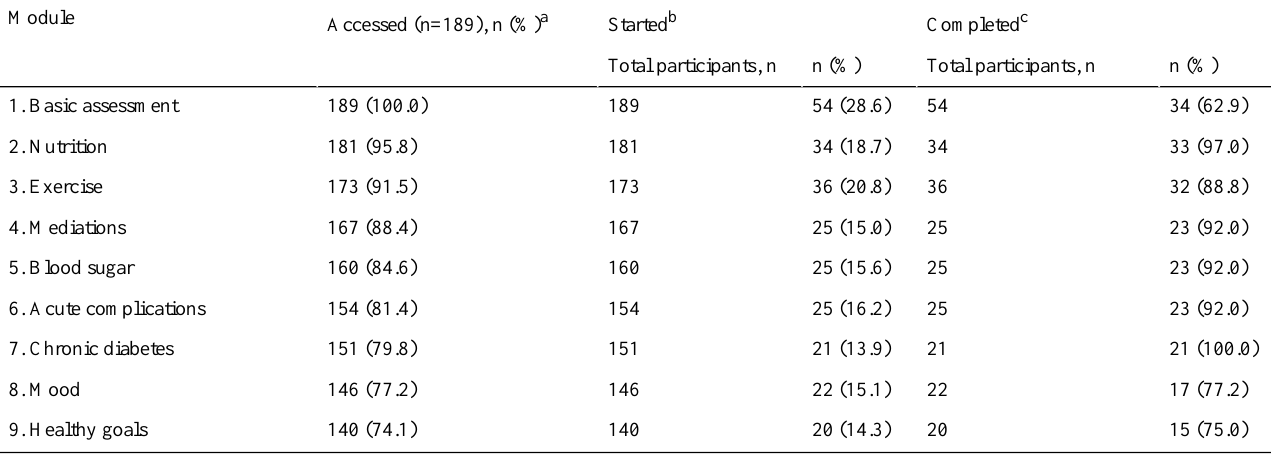
Table 1. Intervention patients (n=189) who accessed, started, and completed particular Diabetes Engagement and Activation Platform modules.